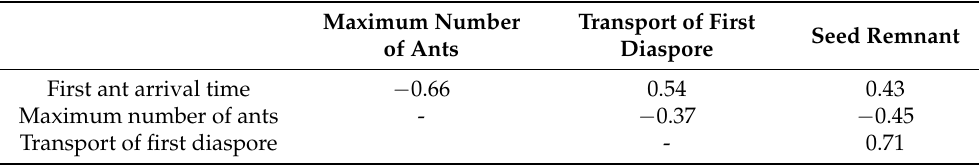
Table 2. Partial correlations controlled for the effect of plant species, treatment and day between measured variables ( n = 500). All correlations are significant at p <